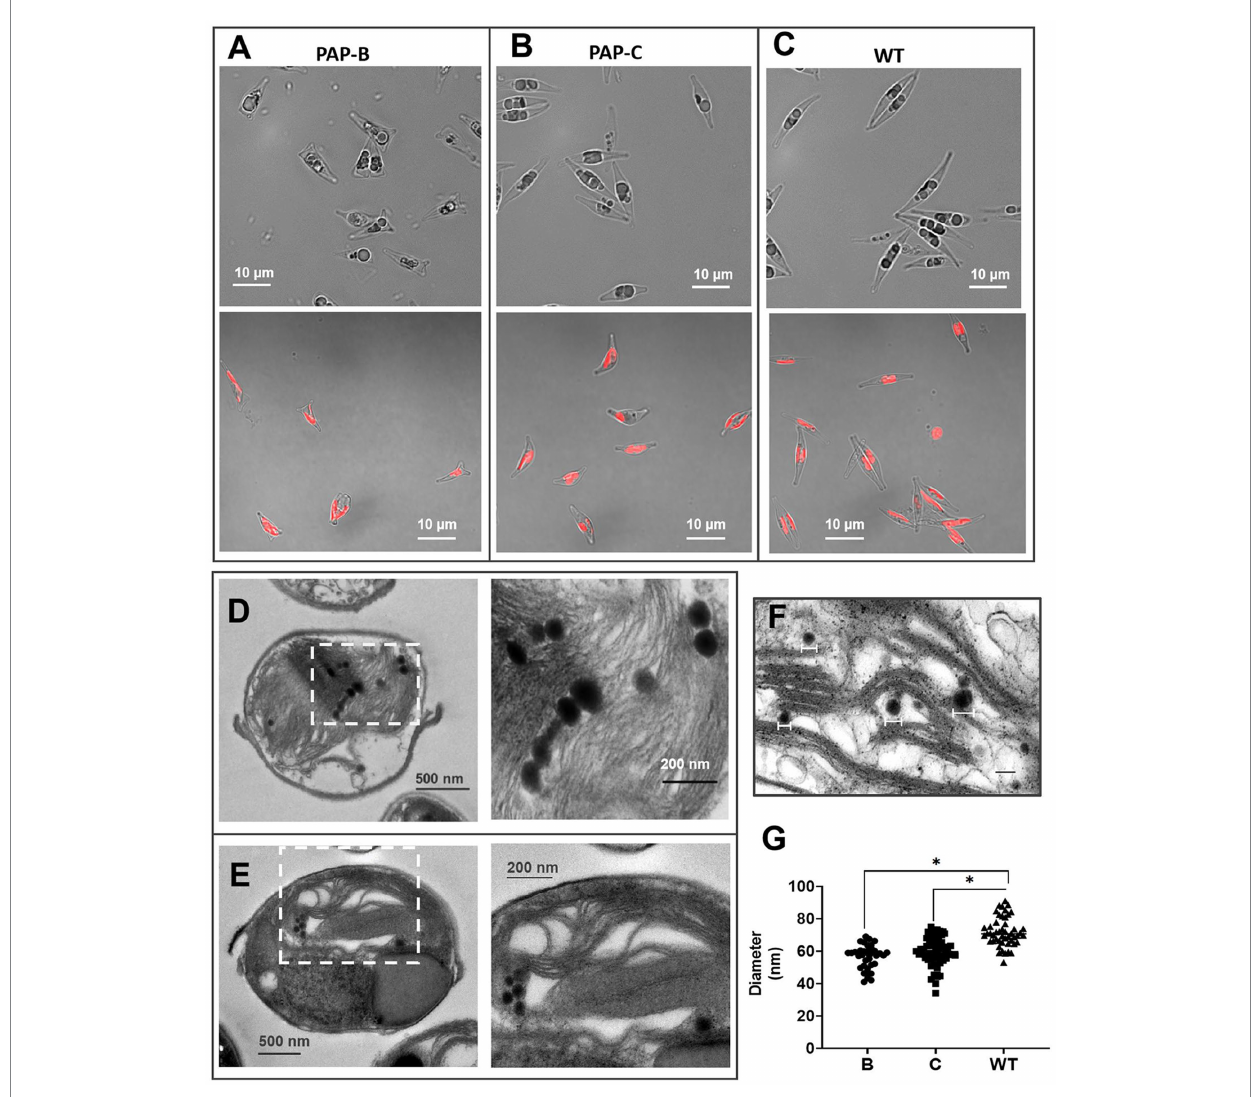
FIGURE 2 Morphological analysis of the mutants and WT. (A–C) Micrographs of PAP-B, PAP-C, and WT. The bottom images present the distribution of spontaneous chlorophyll fluorescence in cells. (D,E) Transmission electron microscopy (TEM) images of the WT and mutants. The right image is a partial enlargement of the left image. (F) ImageJ was used to calculate the diameters of PGs in the TEM images. (G) Statistical analysis of the PG diameters in different